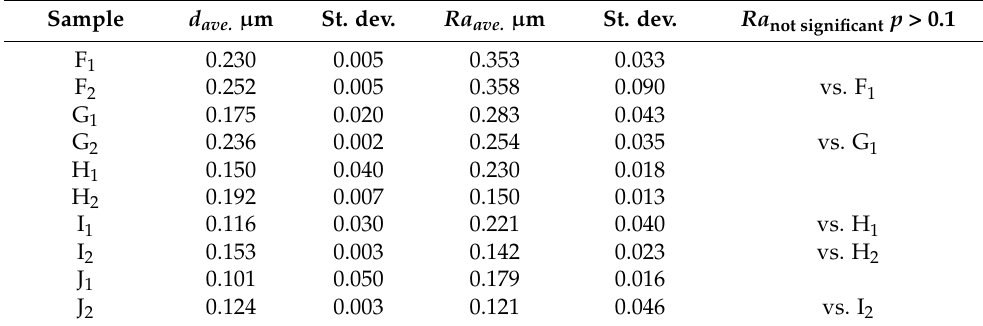
Table 4. Calculated average fiber diameter values ( d ave ., µ m) and surface roughness parameters ( Ra ave , µ m) from AFM images of native and heat-treated samples.